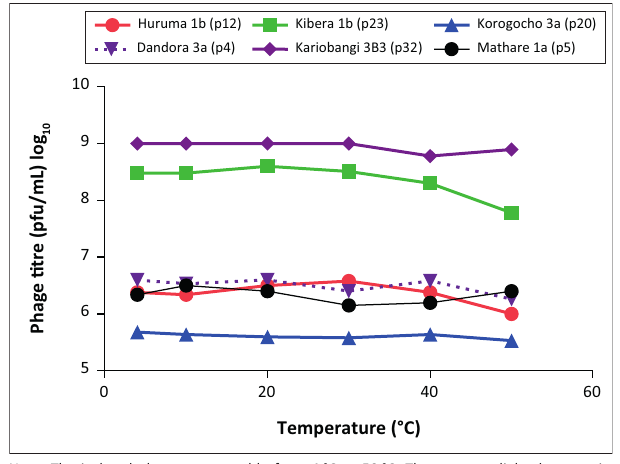
FIGURE 1: Effect of temperature on phages isolated in Nairobi County, Kenya, July 2019 to December 2020. Phages were named based on source and phage